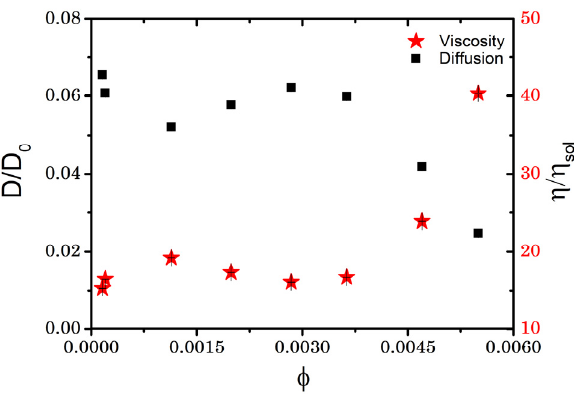
Figure 4. Self-diffusion coefficient (mark ■ ) and viscosity (spot ★ ) for system parameters 𝛾 (cid:4593) = 14.05132 and 𝜅 (cid:4593) = 0.96709 in potential energy function Equation (4) corresponding to the present manuscript’s fitted RMSA S ( k ) for the system with volume fraction φ = 0.00362 of Figure 3. From this ferrofluid, seven other different particle concentrations were studied. Error bars are roughly the same size as symbols.